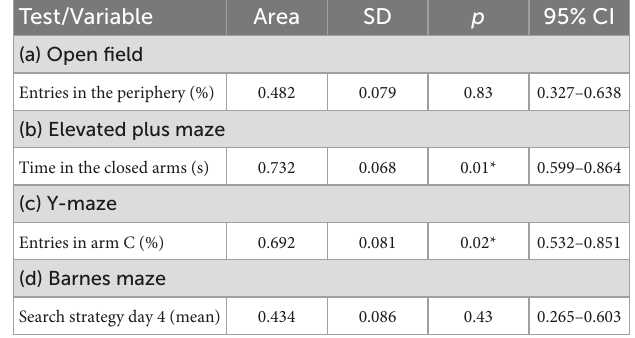
TABLE 1 Receiver operating characteristic curve statistics to detect the extreme behaviors in the ladder walking test.